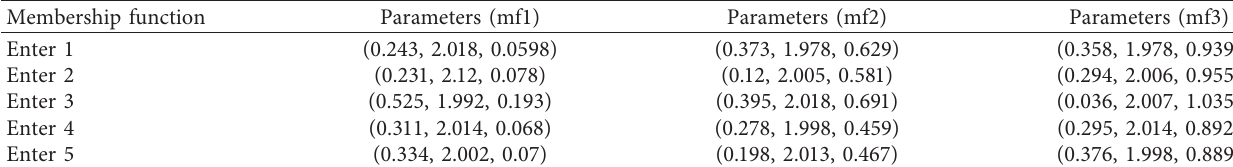
Table 5: Membership function parameters after